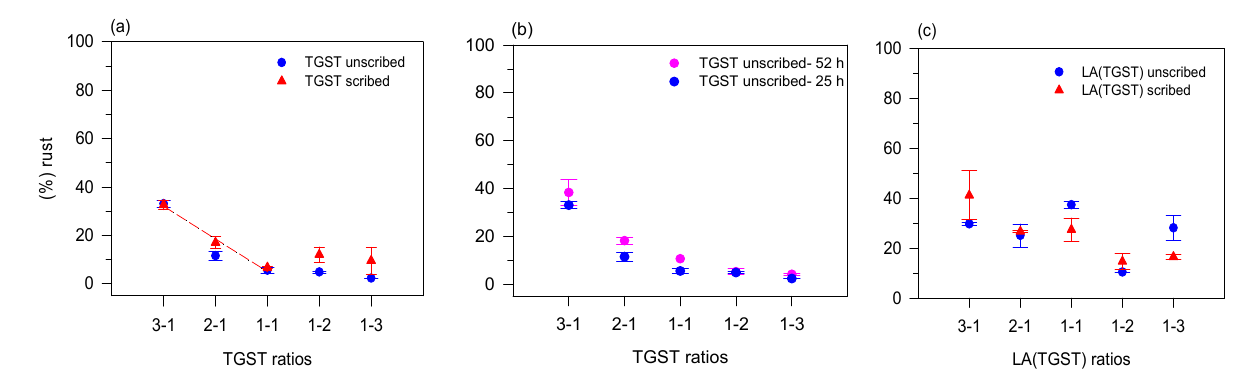
Figure 8. Corrosion prevention performance associated with development of rust on coupons coated with ( a ) TGST and ( b ) LA(TGST) formulations with varying TG:ST stoichiometry between 3:1 to 1:3 after exposure for 25 h in Dilute Harri- son’s Solution (DHS).